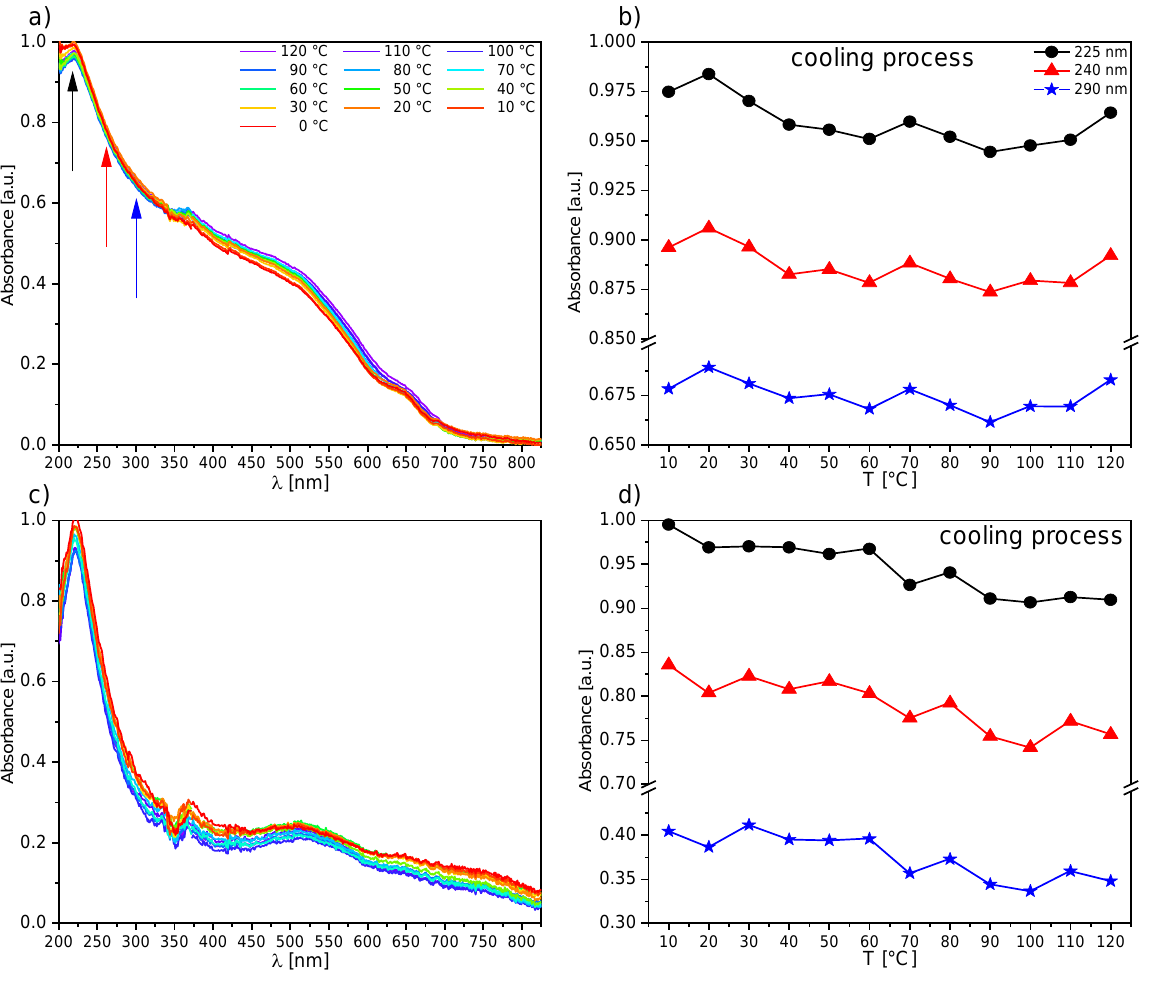
Figure 1. The solid state UV-vis absorption spectra for Sample 1 ( a ) and Sample 2 ( c ) in the 200–850 nm range, as well as the temperature influence on the chosen wavelengths for Sample 1 ( b ) and Sample 2 ( d ). The legend in graph ( a ) is the same for ( c ), while that in graph ( b ) is the same for graph ( d ).